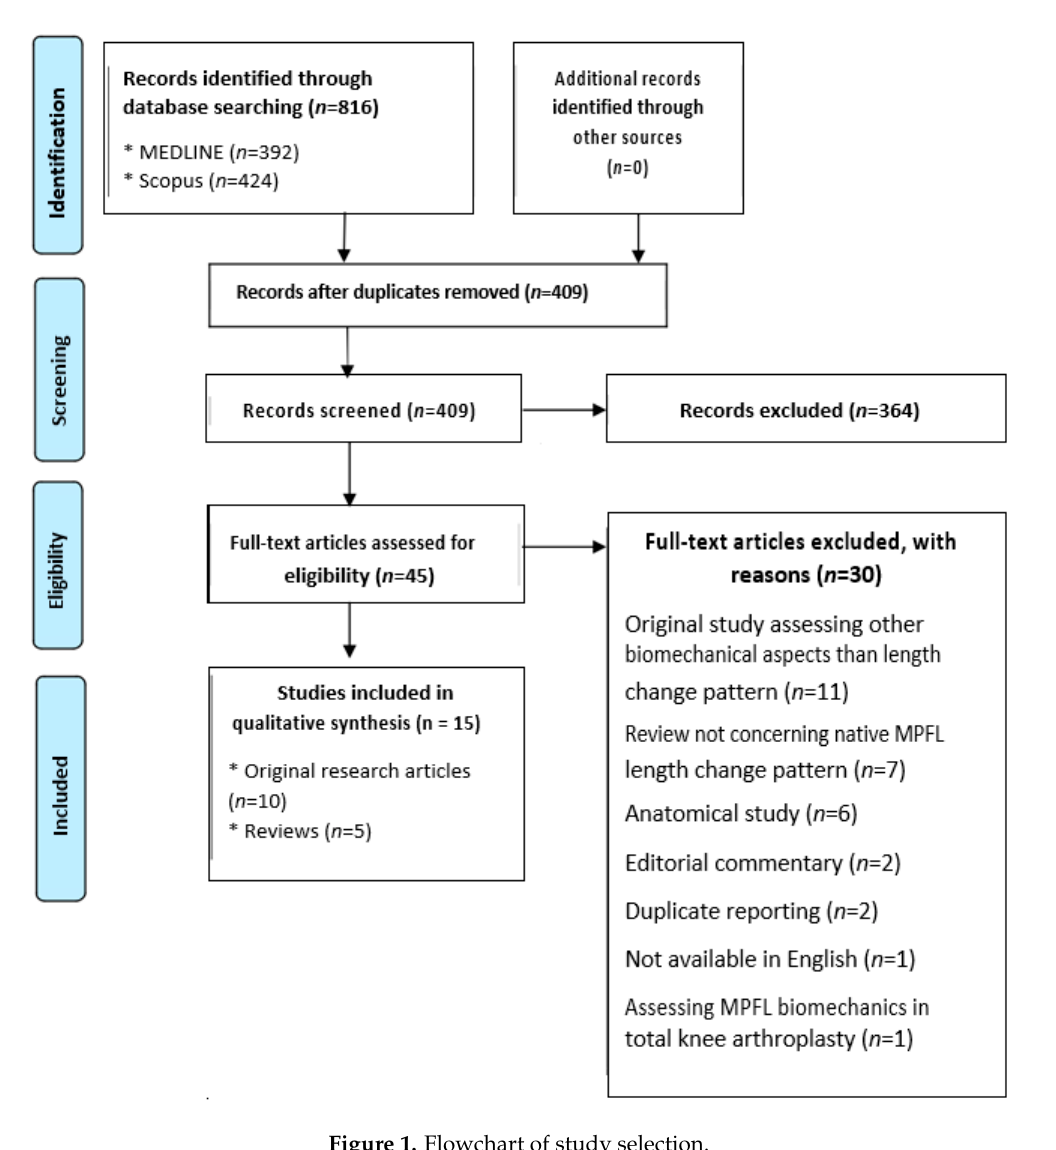
Figure 1. Flowchart of study selection.